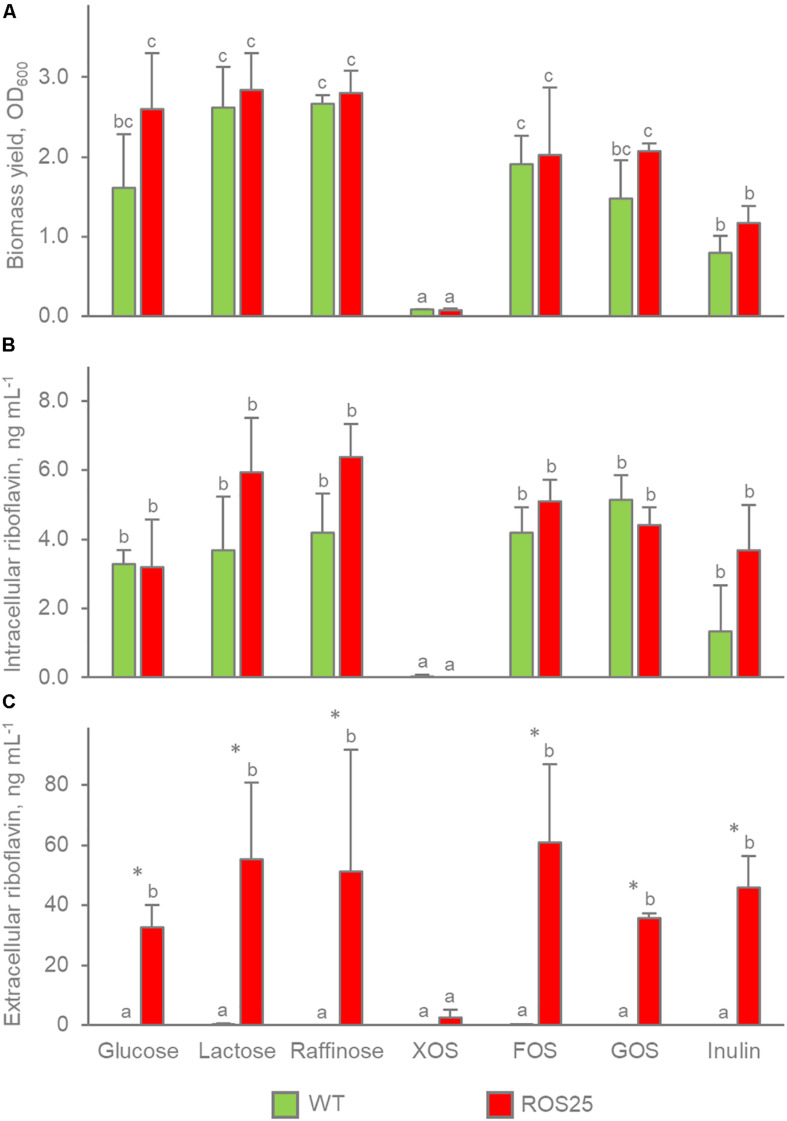
Growth yield (OD600nm) and riboflavin production in batch cultures of ROS25 and wild-type (WT) grown in mSM7 media containing varying carbohydrate sources (1%). (A) OD600nm; (B) intracellular riboflavin ng mL–1 of culture; (C) extracellular riboflavin ng mL–1 of supernatant. Values are means ± SD, n = 3. * indicates statistically significant differences between ROS25 and WT samples (P < 0.05); lowercase letters indicate statistical significant differences for the same strains on the diverse carbon sources between (p-value < 0.05).